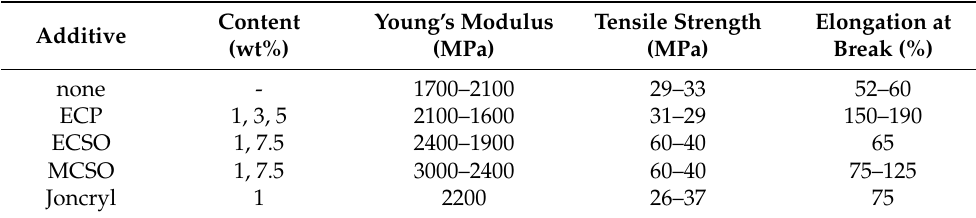
Table 3. Mechanical features of PLA/PBAT 80/20 blends treated with different biobased chain extenders (from Refs